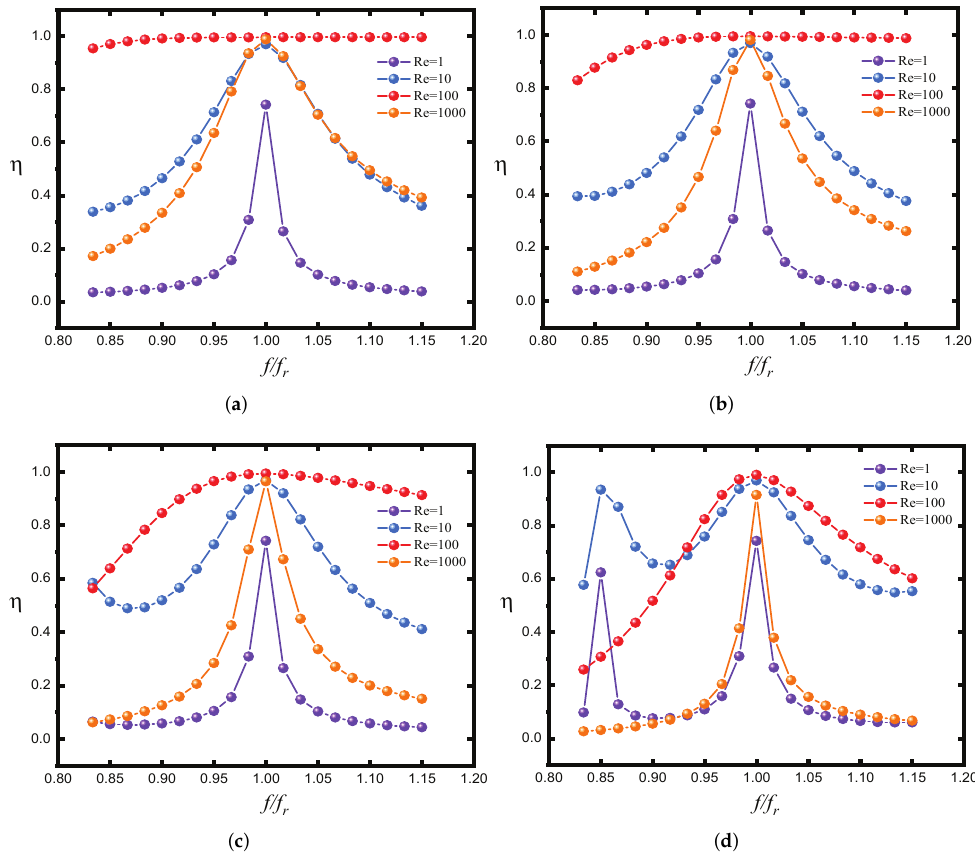
Figure 5. Variation of power transmission efficiency with working frequency ( L p = L s = 52 µ H; R p = R s = 0.31 Ω ; C p = C s = 5.43 nF; f r = 300 kHz). ( a ) k = 0.96. ( b ) k = 0.77. ( c ) k = 0.58. ( d ) k = 0.38.